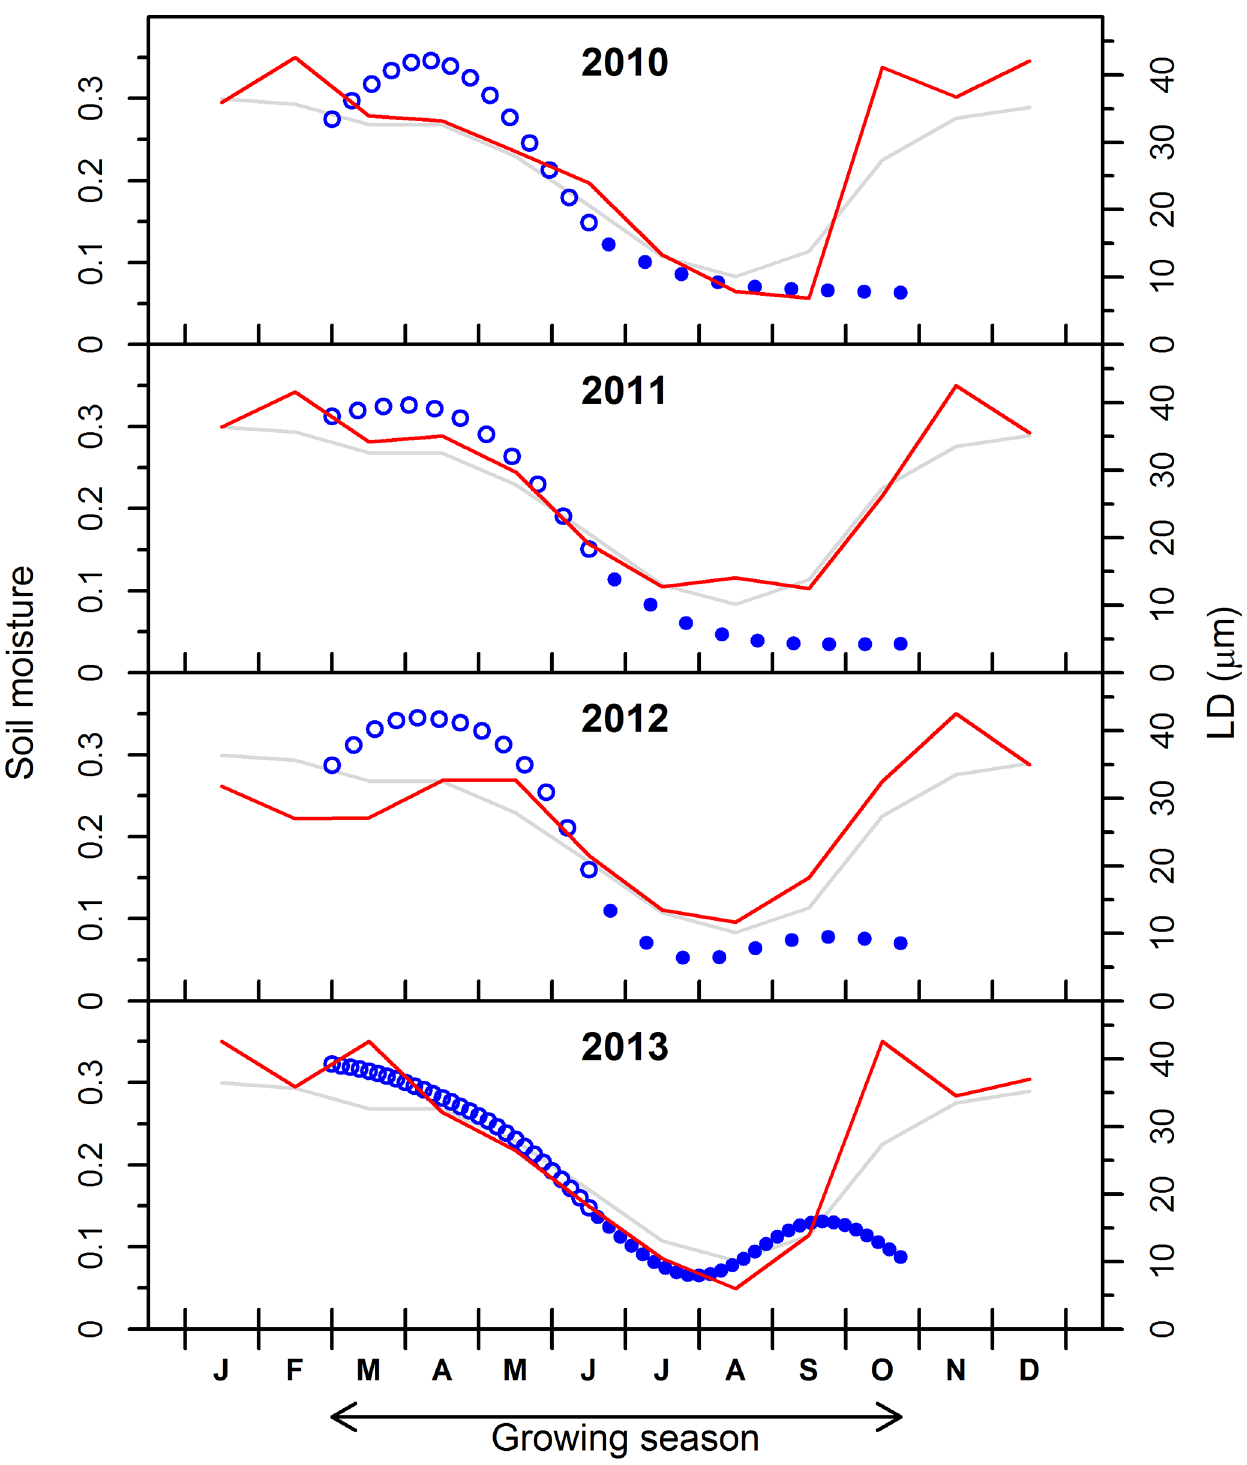
Fig 5. Synchronization of the intra-ring variation of lumen diameter (LD) and sub-seasonal variation of water balance for the period 2010 – 2013. Open and solid dots indicate the LD of earlywood and latewood tracheids, respectively. Red line indicates the soil moisture for each studied year. Grey line indicates the average soil moisture for the last 30